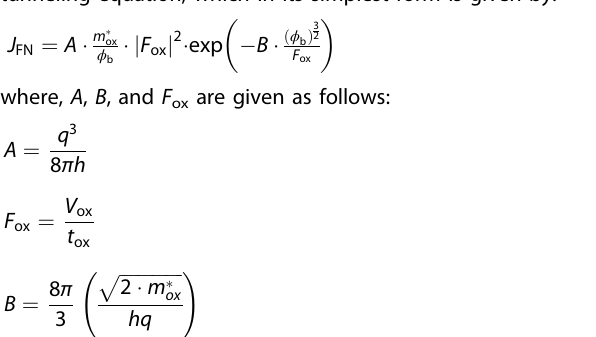
! ffiffiffiffiffiffiffiffiffiffiffiffiffiffi p 2 (cid:3) m (cid:4) ox hq